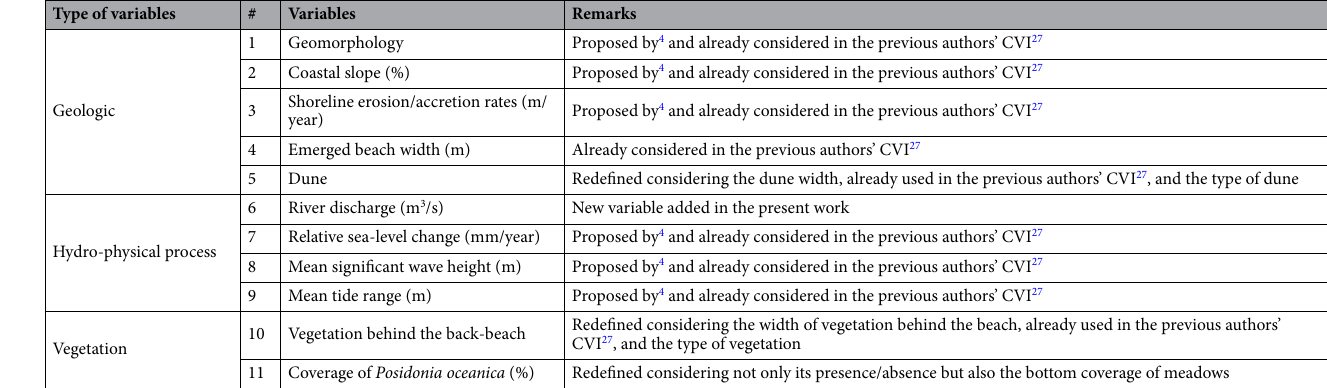
Table 2. Variables used in the proposed CVI